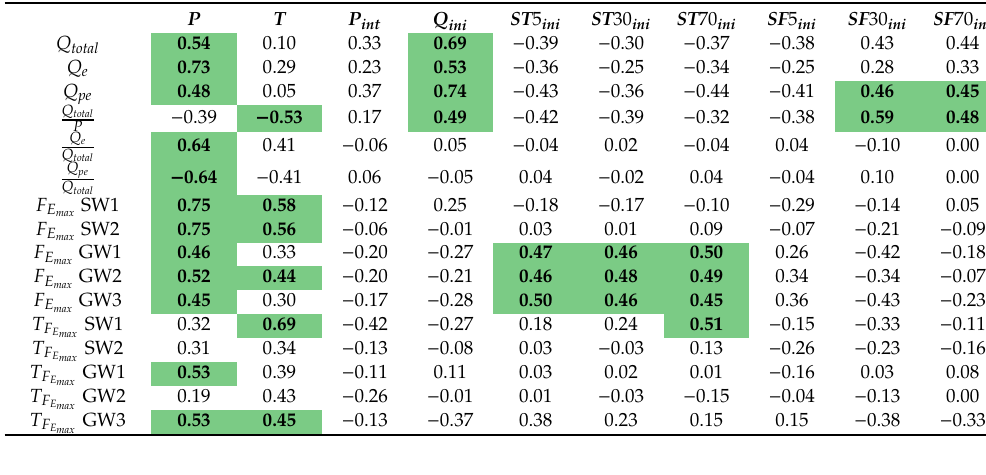
Table 2. Spearman rank correlation coe ffi cients ( p ) for the relationships of precipitation and antecedent wetness characteristics with discharge characteristic, maximum event water fraction and its response time (see Table 1 for acronyms). Green bolded cells represent statistically significant correlations with p < 0.05.